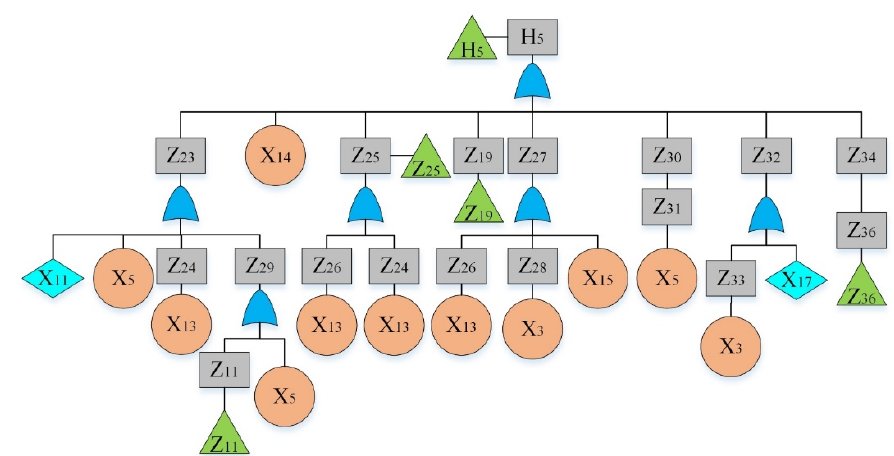
Figure 6. Fault tree of a hydraulic system: sub-tree IV.